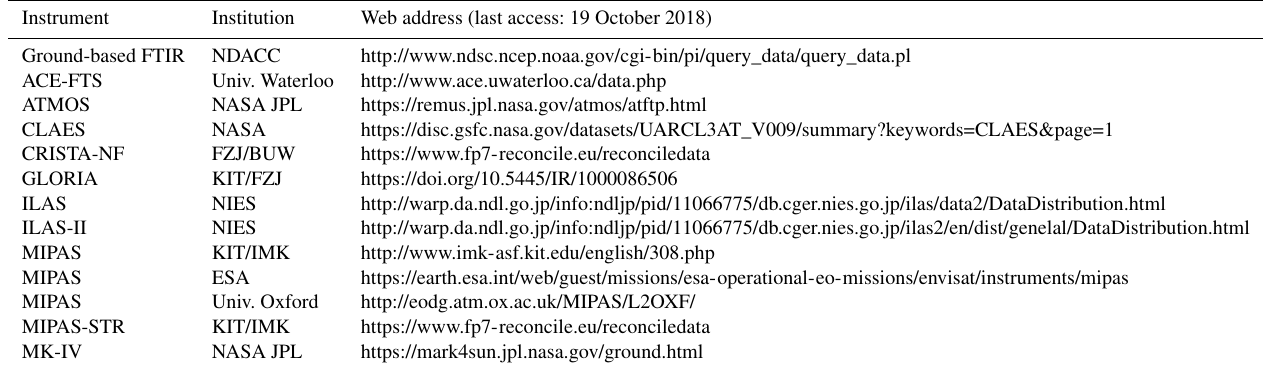
Table 5. Sources of ClONO 2